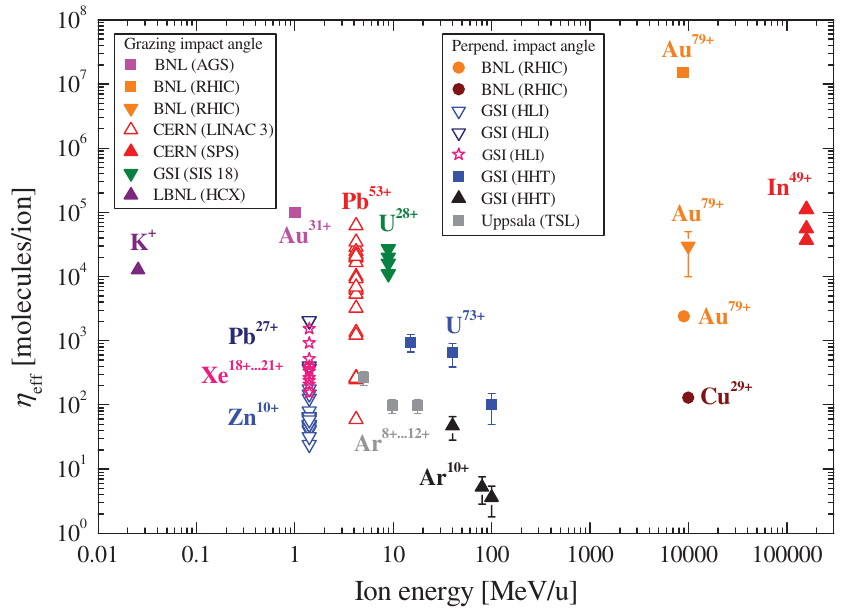
FIG. 5. (Color) Overview of heavy-ion-induced desorption data (status August 2008) classified in experiments with either grazing or perpendicular ion-impact angles. The measurements were made at BNL [5,22,23], CERN [29–31], GSI [7,33,36,45,46,53], LBNL [37], and Uppsala